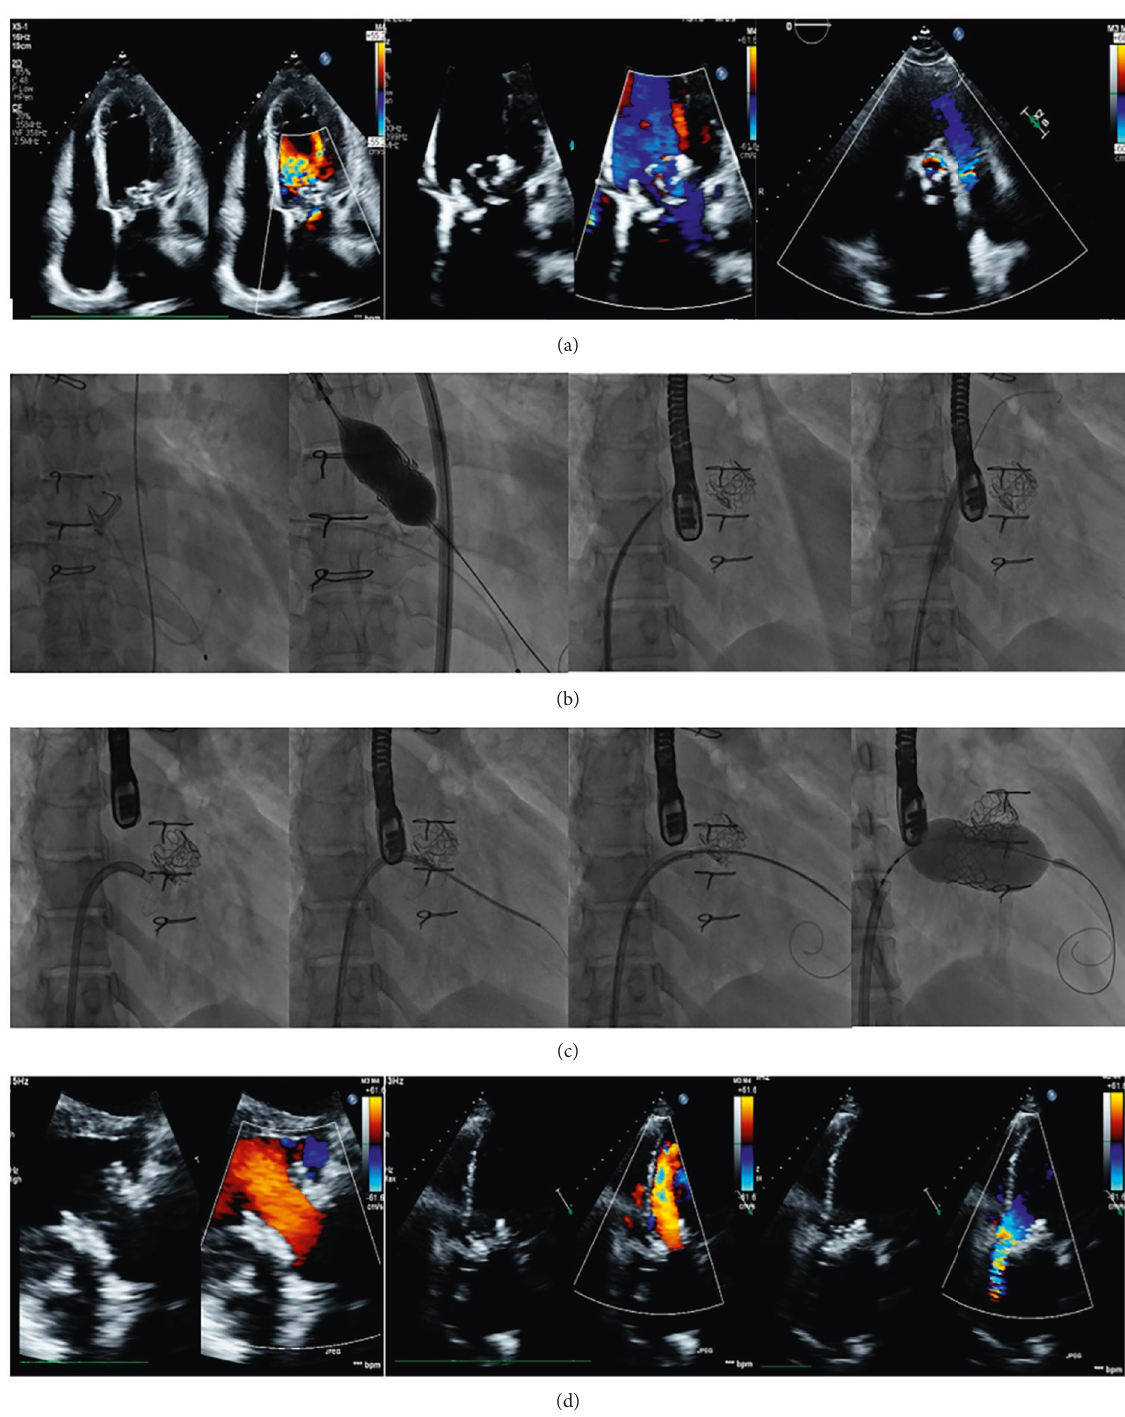
Figure 3: Transcatheter mitral valve in a degenerated EPIC ™ (St. Jude Medical) valve (TMViV) with a concomitant transcatheter aortic valve implantation (TAVI). A 49-year-old old female patient with COPD had a degenerated bioprosthetic 29mm EPIC ™ MV and a degenerated bioprosthetic AV with an associated AF. TTE shows a degenerated bioprosthetic 29mm EPIC ™ MV (severe MS) and a degenerated bio- prosthetic AV (severe AS). (b) Fluoroscopy shows the crossing of degenerated bioprosthetic AV with a 5F Amplatz left catheter over a 0.035- inch curved Terumo guidewire, followed by transaortic TAVI of an Edwards SAPIEN 3-26mm valve during rapid pacing. Transseptal puncture using a 0-1 BRK ™ within an 8.5F-SL sheath, followed by balloon dilatation of the transseptal puncture using a 12mm balloon. (c) Fluoroscopy shows a transseptal TMViV of an Edwards SAPIEN-3 29-mm valve. First, an 8.5F-agilis ™ sheath was flexed and directed towards the degenerated bioprosthetic MV. Second, a 5F-MP catheter over a 0.035-inch curved Terumo guidewire crossed the MV to the LV. Third, the wire was exchanged with a 0.035-inch/260 extra-stiff Confida ™ guidewire. And finally, THV implantation. TTE: both SAPIEN-3 valves are in mitral and aortic positions with normal flow across both valves. AF: atrial fibrillation, AS: aortic stenosis, AV: aortic valve, COPD: chronic obstructive pulmonary disease, MS: mitral stenosis, MV: mitral valve, MVA: mitral valve area, Pg: pressure gradient, TAVI: transcatheter aortic valve implantation, TMViV: transcatheter mitral valve-in-valve, TTE: transthoracic echocardiography, and THV: transcatheter heart